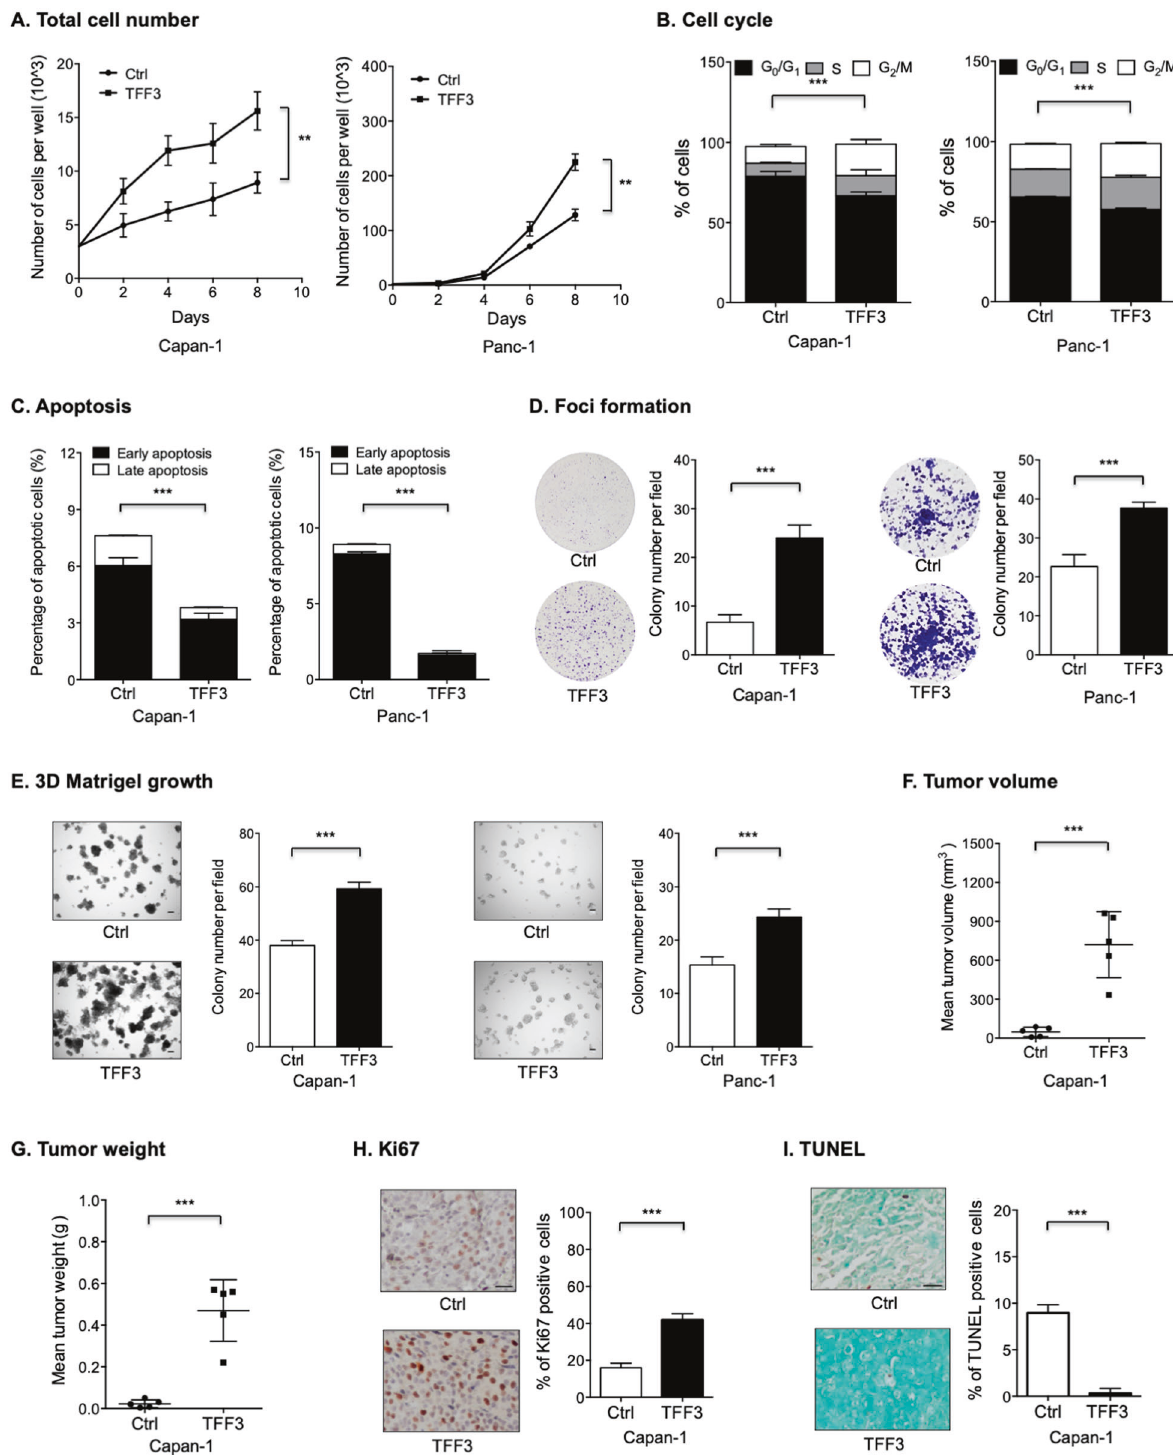
Fig. 2 Forced expression of TFF3 promoted oncogenicity of PDAC cells. A Total cell number analysis was performed to determine the effect of forced expression of TFF3 on cell proliferation in Capan-1 and Panc-1 cells. B Cell-cycle progression change of Capan-1 and Panc-1 cells after forced expression of TFF3 was determined using PI staining followed by FACS analysis. The percentages of cells in each cell-cycle phase were plotted. C Apoptosis of Capan-1 and Panc-1 cells after forced expression of TFF3 was determined using AnnexinV/PI staining followed by FACS analysis. The percentages of cells in an early or late apoptotic phase were plotted. D Foci formation assay was performed to determine the effect of forced expression of TFF3 on foci formation by Capan-1 and Panc-1 cells. E 3D-Matrigel analysis was performed to determine the effect of forced expression of TFF3 on 3D growth of Capan-1 and Panc-1 cells. Scale bar, 50 μ m. F – G The volume ( F ) and weight ( G ) of xenografts formed by Capan-1-TFF3 or the control cells at the termination of the experiment. H Representative micrographs and quantitative assay of IHC staining for Ki67 in the indicated xenografts. Scale bar, 20 μ m. I Representative micrographs and quantitative assay of TUNEL staining in the indicated xenografts. Scale bar, 20 μ m. Cell Death and Disease (2022)